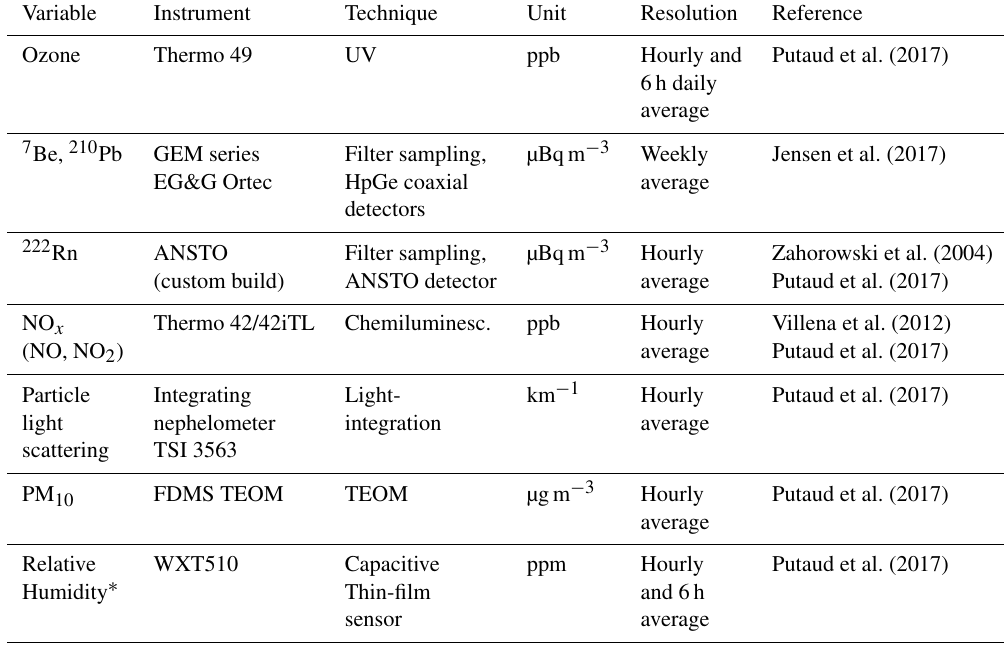
Table 1. Instruments and measurements at the JRC Ispra site.